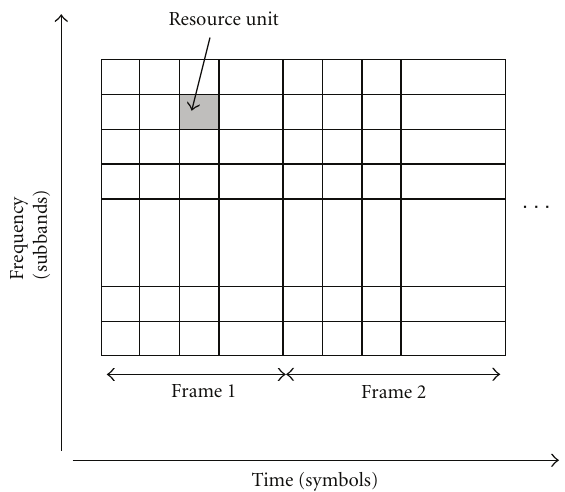
Figure 1: Two-dimensional resources in OFDMA systems.